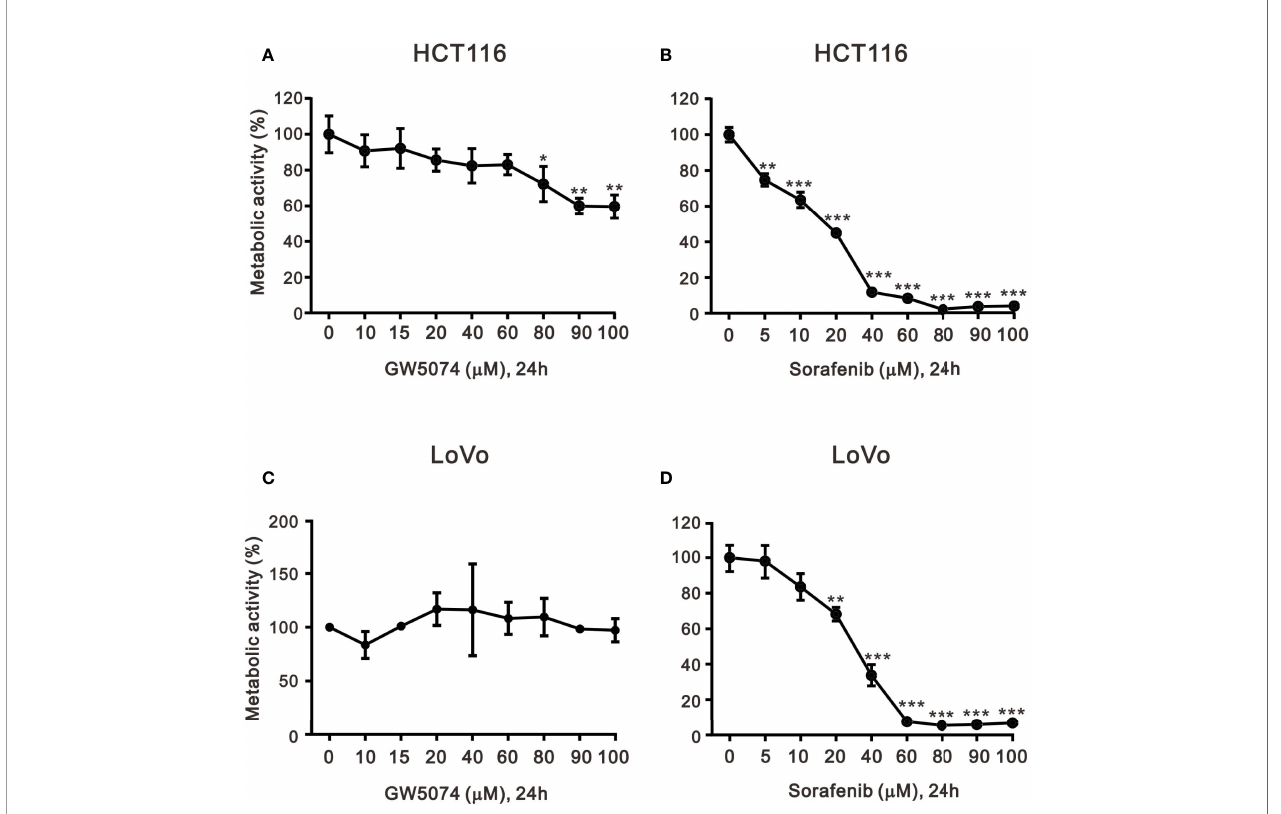
FIGURE 1 | The effects of GW5074 and sorafenib on the cytotoxicity of HCT116 and LoVo cells. HCT116 and LoVo cells (A, C) were treated with 0, 10, 15, 20, 40, 60, 80, and 100 µM GW5074 for 24 h; (B, D) were treated with 0, 5, 10, 20, 40, 60, 80, 90, and 100 µM sorafenib for 24 h. Metabolic activity was measured using MTS assays. The results are representative of three independent experiments. * p < 0.05, ** p < 0.01, and *** p < 0.001.